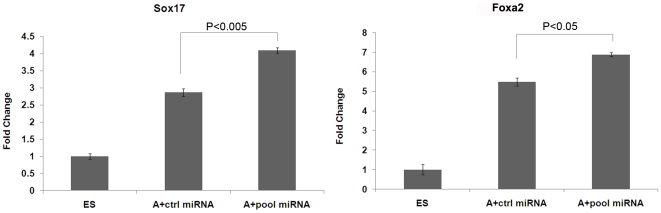
Over-expression of pooled miRNAs partially increases the expression of DE markers.Mouse ESCs were treated with 100 ng/ml Activin A for three days, then transfected with pooled miRNAs to allow further differentiation for 2 more days. Cel-miR-67 was use as a negative control. The expression of two DE markers Sox17 and Foxa2 was analyzed by RT-qPCR. The expression of these two markers was significantly increased after treating with pooled miRNAs as compared to the control cells (P = 0.003 for Sox17, and P = 0.028 for Foxa2). Data are expressed as mean fold change ± SD. A: Activin A.